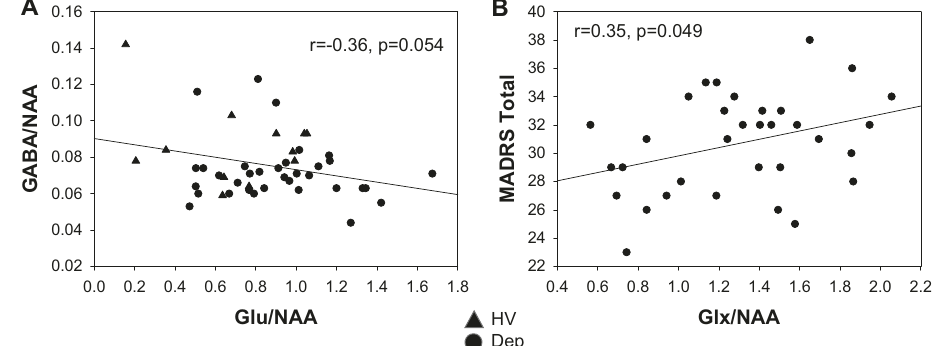
MDD major depressive disorder, HV healthy volunteer, MDE major depressive episode, MADRS Montgomery – Åsberg Depression Rating Scale. a GABA/NAA subsample included 12 HV (6 female and 6 male). * P <0.05 compared to female MDD and HV.